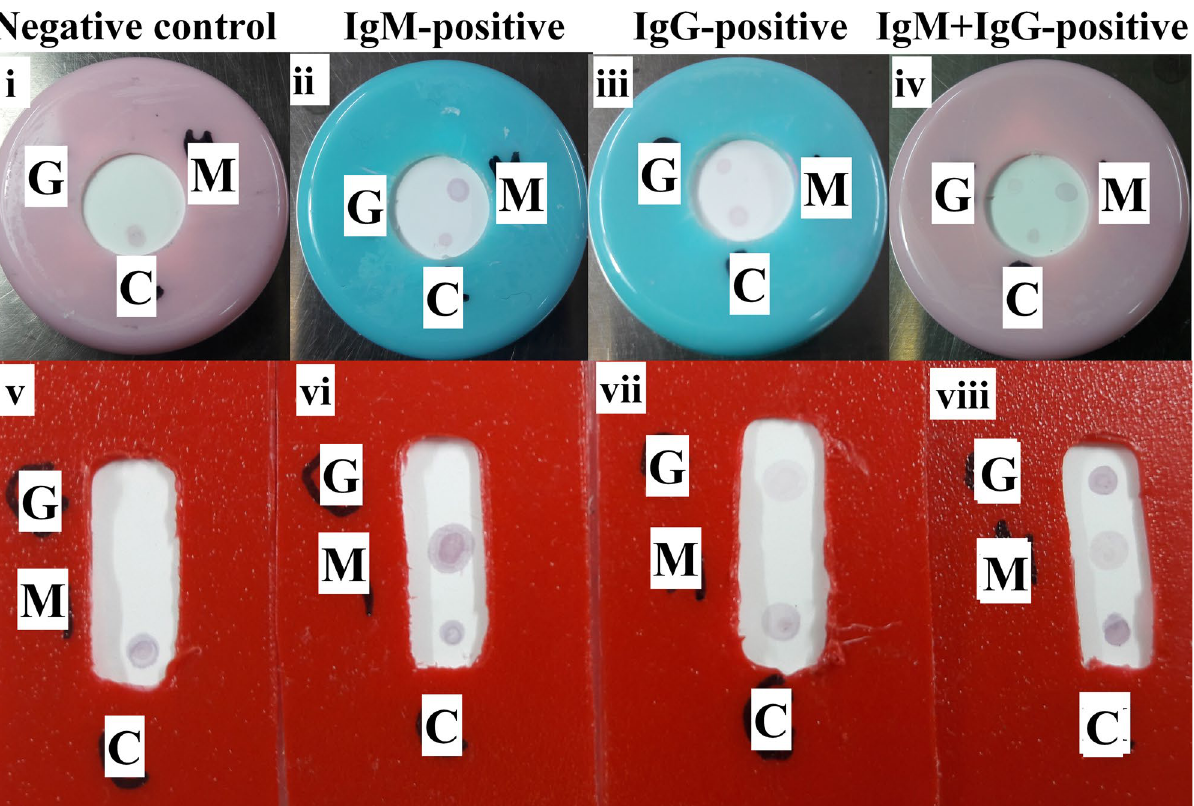
Figure 5. Testing of COVID-19 PCR positive sera using TLTD format 1 (i–iv) and format 4 (v–viii). Where G: expected positive area for IgG against S protein; M: serum positive for IgM against S protein and C: positive control. Column Negative control: normal serum; Column IgM-positive: anti-SARS-CoV-2 IgM Abs positive serum; Column IgG-positive: anti-SARS-CoV-2 IgG Abs positive serum and Column IgM + IgG-positive: anti- SARS-CoV-2 IgM and IgG positive serum. All sera at the dilution